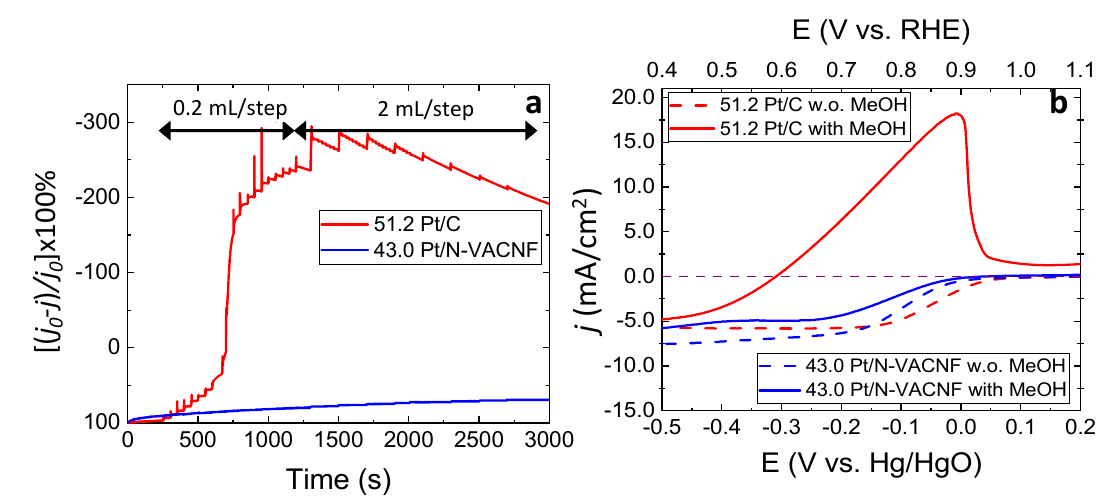
Figure 7. ( a ) Amperometric j-t curve of Pt/C (51.2 µg/cm 2 ) and Pt/N-VACNF (43.0 µg/cm 2 ) recorded at 1600 rpm in O 2 -saturated 0.10 M KOH solution with successive addition of 3.0 M methanol to the final concentration of 0.75 M at the potential of –0.1 V (vs. Hg/HgO); ( b ) LSV curves recorded at a scan rate of 10 mV/s and 1600 rpm in 0.10 M KOH + 0.75 M MeOH for Pt/C (51.2 µg/cm 2 ) and Pt/N-VACNF (43.0 µg/cm 2 ). The purple dash line marks the zero current density.